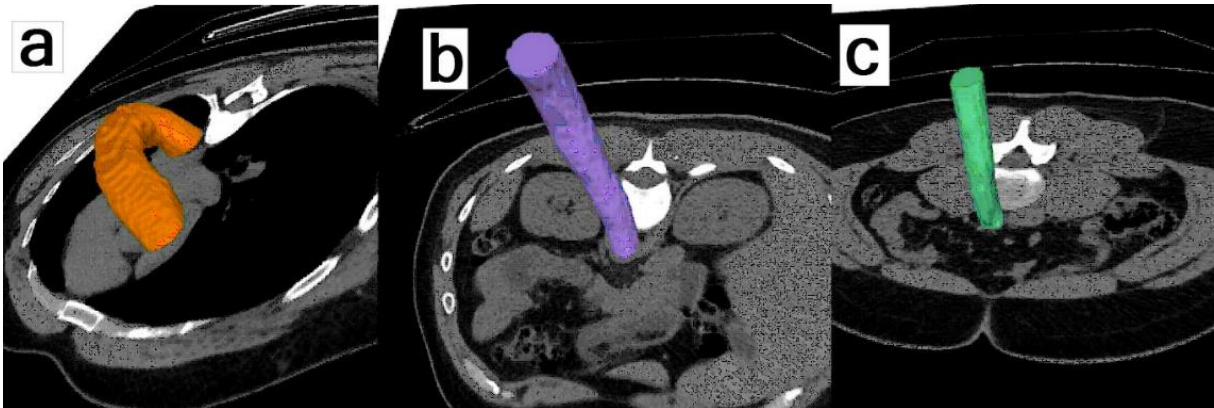
Figure 5 . Artificial Intelligence-Based Segmentation of the Aorta. Convolutional neural networks trained on manually annotated non-contrast CT images allows reconstruction of the arch of aorta ( a ), thoracic aorta ( b ), and abdominal aorta ( c ). After identifying the edge of the aorta, segmentation of the wall (not shown) is made by including all voxels lying within 3 mm of the edge of the aorta segmentation on the inside and within 2 mm of the edge on the outside, yielding a 5 mm thick wall following the edge of the aorta segmentation output from the segmentation tool. This yielded a 5 mm thick wall following the edge of the aorta. Values obtained with this approach for average NaF SUVmean uptake in the walls of three sections were very virtually identical to values obtained by manual segmentation. Reprinted with permission from Piri et al [71]). 2021, Springer Nature.